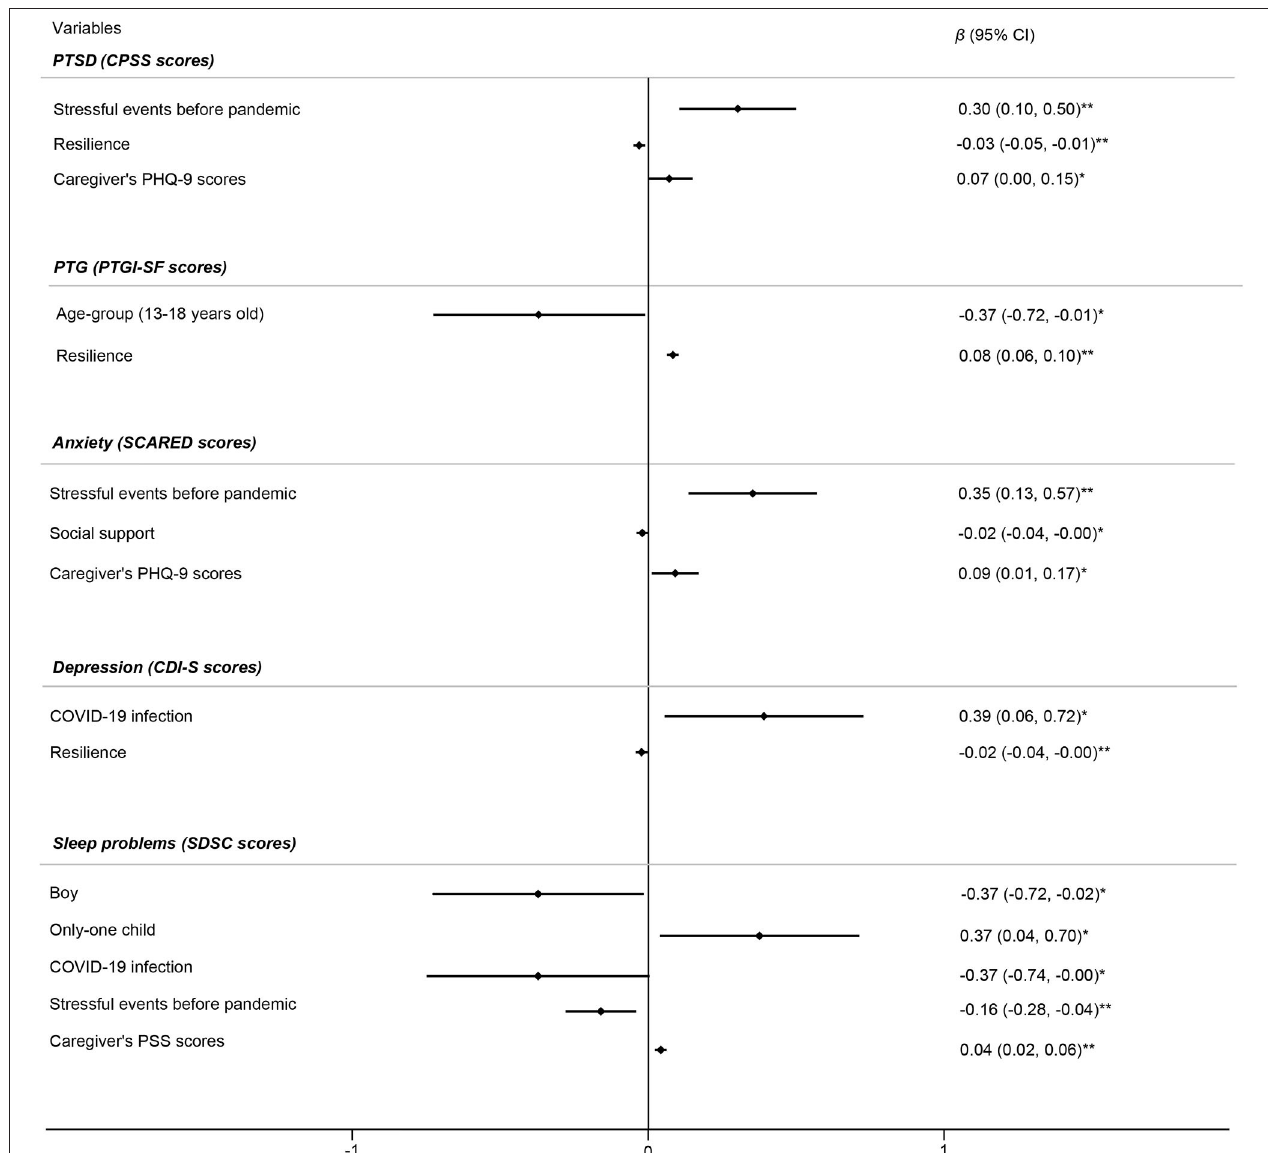
FIGURE 1 | Factors associated with mental health symptoms in children ( n = 152). Initial variables in the multivariate linear regression model for PTSD included gender, age group, COVID-19 diagnosis, stressful events before the pandemic, resilience, social support, and caregivers’ PSS and PHQ-9 scores. Initial variables in the multivariate linear regression model for PTG included gender, age group, COVID-19 diagnosis, stressful events before the pandemic, resilience, social support, and caregivers’ PSS and PHQ-9 scores. Initial variables in the multivariate linear regression model for anxiety included gender, age group, COVID-19 diagnosis, stressful events before the pandemic, resilience, social support, and caregivers’ PHQ-9 scores. Initial variables in the multivariate linear regression model for depression included gender, age group, COVID-19 infection, nuclear family, stressful events before the pandemic, resilience, and social support. Initial variables in the multivariate linear regression model for sleep problems included gender, age group, COVID-19 diagnosis, being an only child, stressful events before the pandemic, and caregivers’ PSS and PHQ-9 scores. Independent variables in the final model were determined using forward selection. * p < 0.05, ** p <